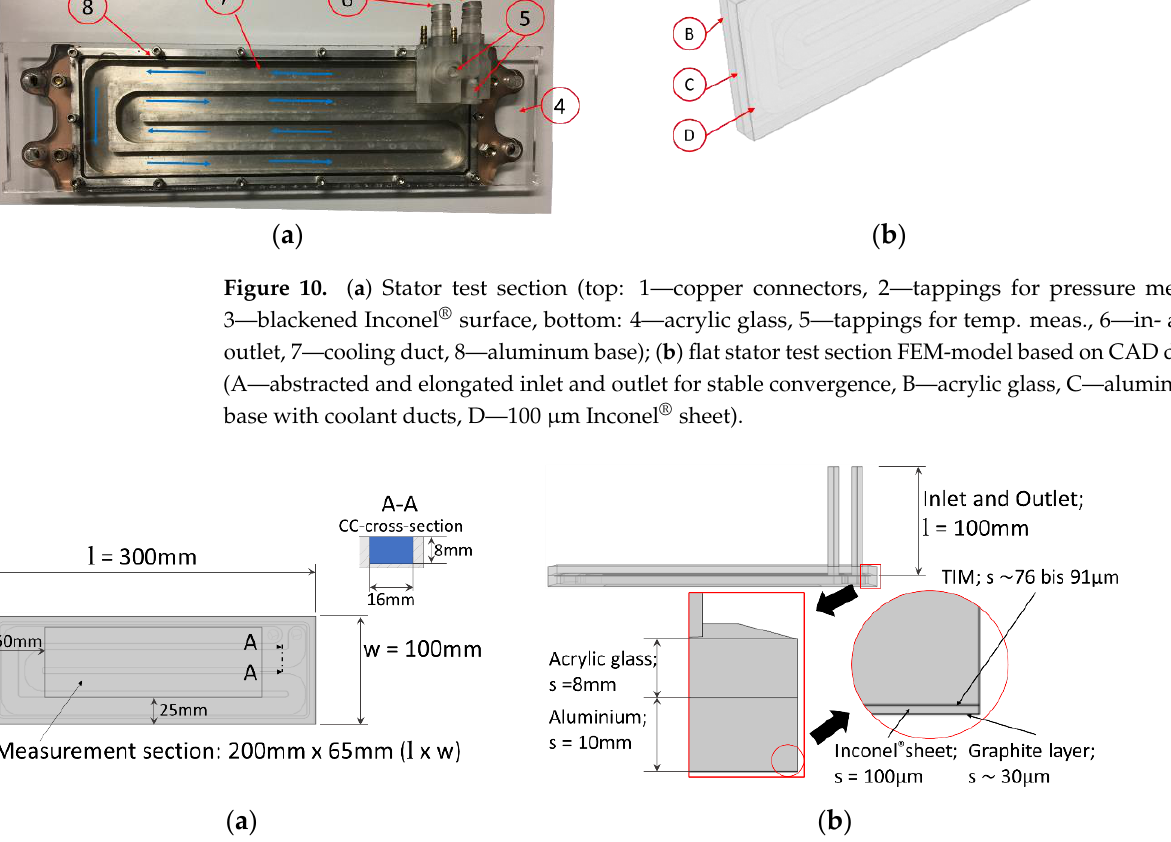
Figure 11. ( a ) Frontal view of the flat test section with dimensional data; ( b ) side view of the flat test section with the structure of the layering and corresponding thicknesses s.